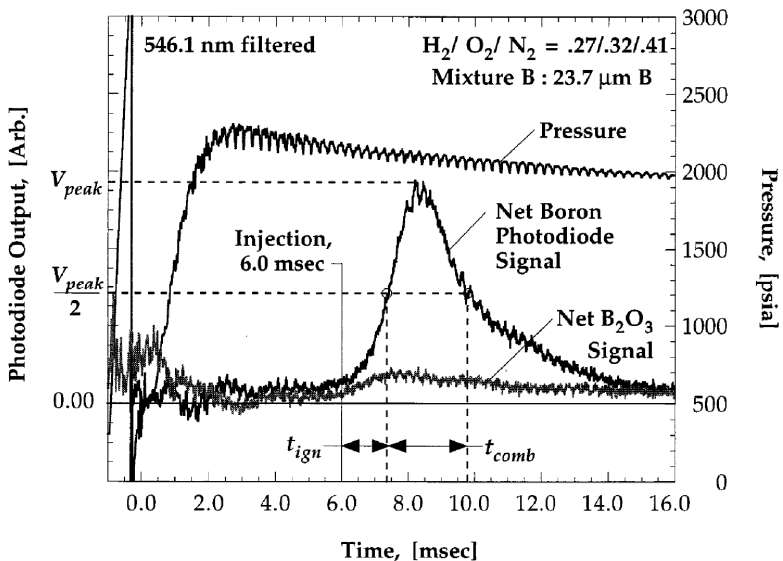
Figure 14. Filtered at 546.1 nm signal of B particle burning in gas mixture (H 2 / O 2 / N 2 = 27 / 32 / 41). Reproduced from [52], with permission from Elsevier, 1999.